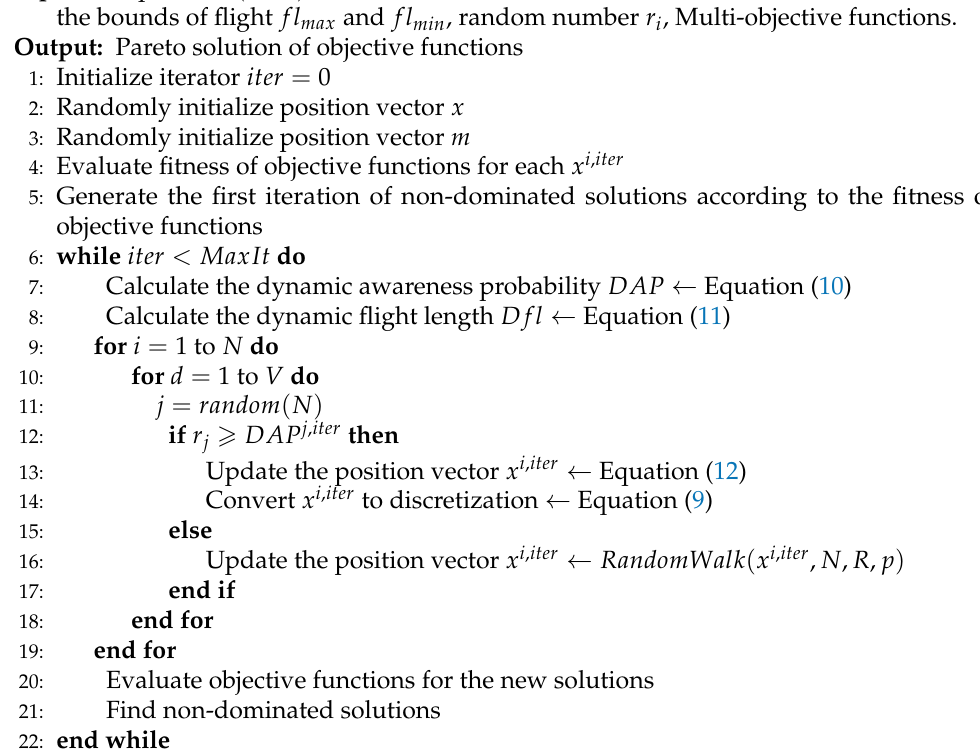
Algorithm 2 MOCSA for